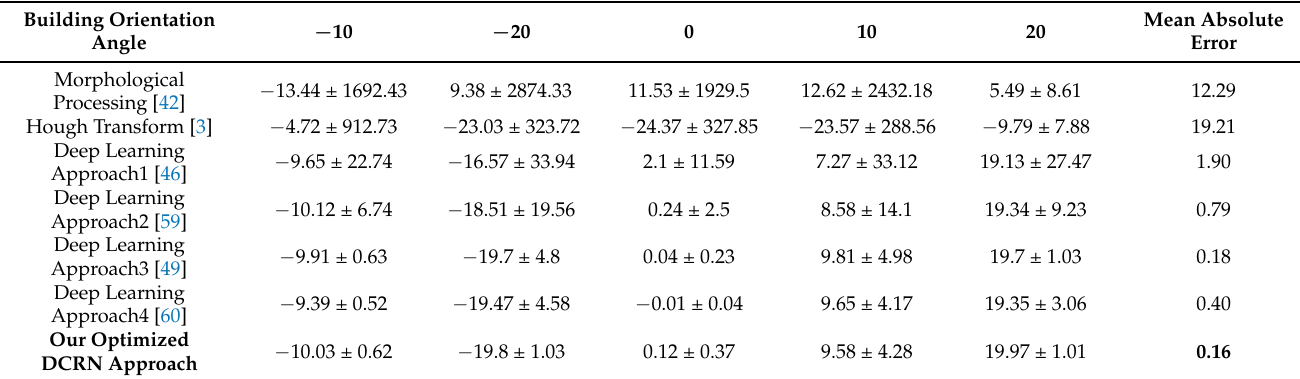
Table 6. Our proposed building orientation angle estimation mean ± variance results vs. previous methods for all test set